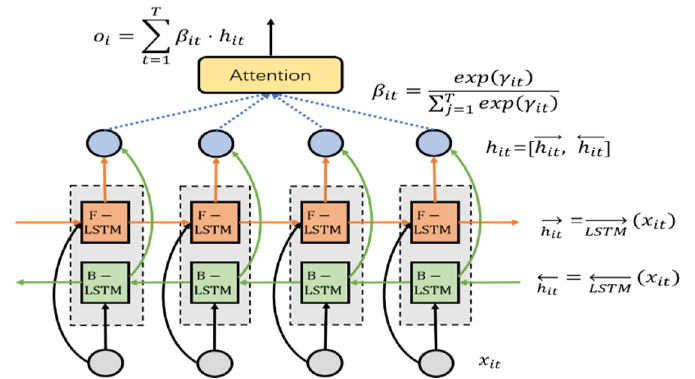
Figure 8. Connections depicting the structure of the BiLSTM model with the attention mechanism at a time step.